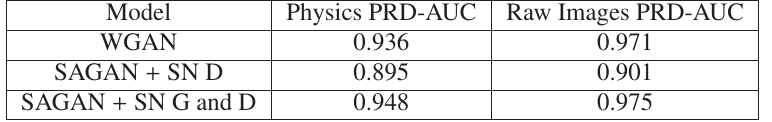
Figure 3: WGAN trained on log energies generated samples example.